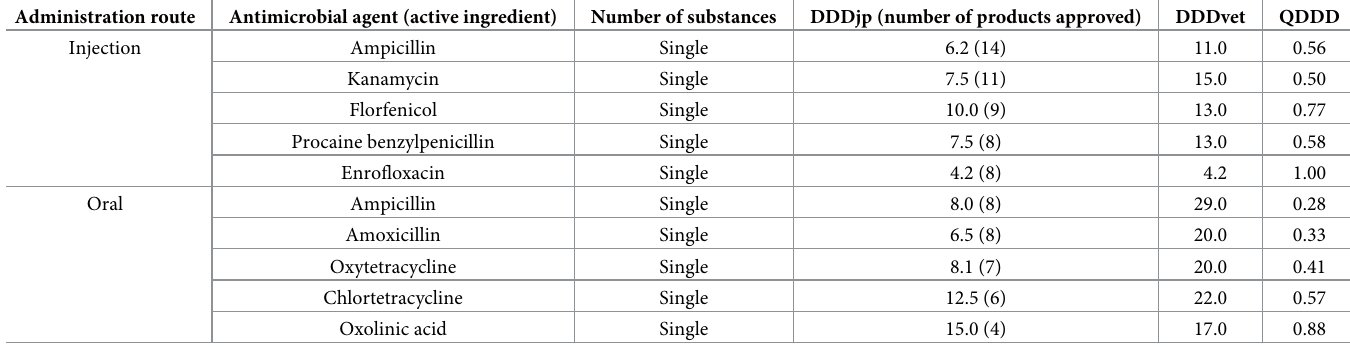
The comparison within this study shows that the medians of DDDjp and DDDvet values differ significantly, and that DDDjp values of some antimicrobial agents have considerable devia- tions from corresponding DDDvet values, e.g. the DDDjp value of 2.1 for procaine-penicillin/ injection/single substance/pigs, which is more than 79% lower than DDDvet. Deviations have been observed in previous studies that compared the difference between DDDvet and DDD values of individual countries: A study conducted in Canada found that in developing their country-specific DDD values, the majority of their DDD values were lower than their Table 7. Average daily doses (DDDjp) of the most frequently approved antimicrobial agents (divided by administration routes) for use in cattle in Japan and their comparison with the values of the European Medicines Agency (DDDvet) based on calculated quotients (QDDD). Administration